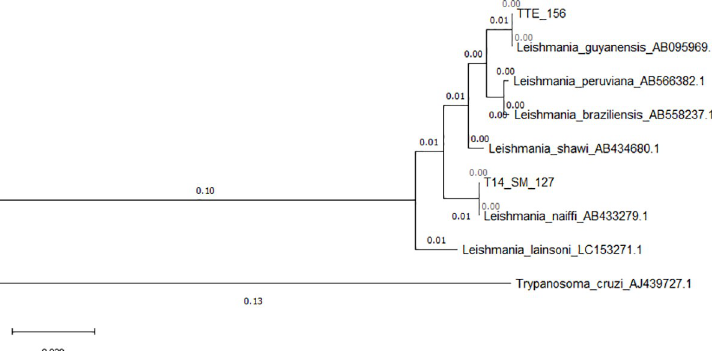
Fig 5. Maximum likelihood tree for Leishmania species in Lutzomyia spp. based on cytochrome b ( cytB ) sequences. TTE-156 = Lu . carrerai carrerai from Madre de Dios (low jungle) and T14-SM127 = Lu . hirsuta hirsuta from San Martin (high jungle). The numbers on the branches represent bootstrap support and the size bar indicates 0.02 substitutions per site. The tree was rooted with the sequence of Trypanosoma cruzi .